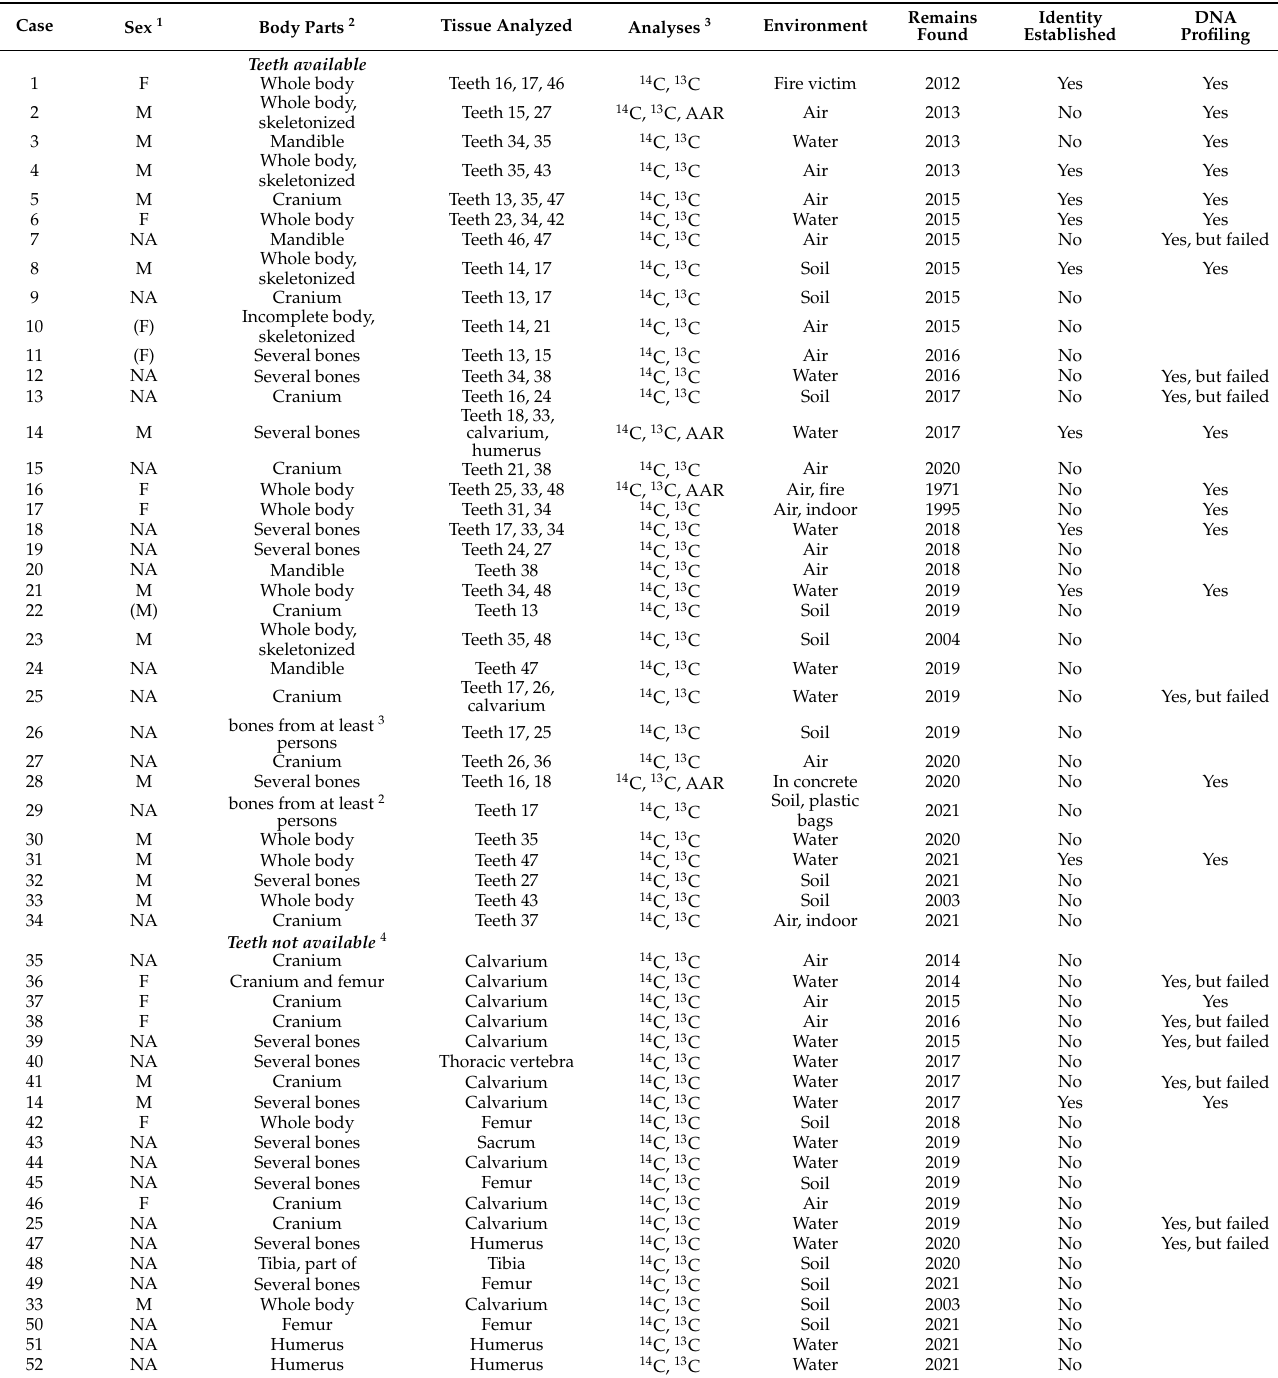
Table 1. Demographic information for the data used in the analysis of F 14 C, δ 13 C and